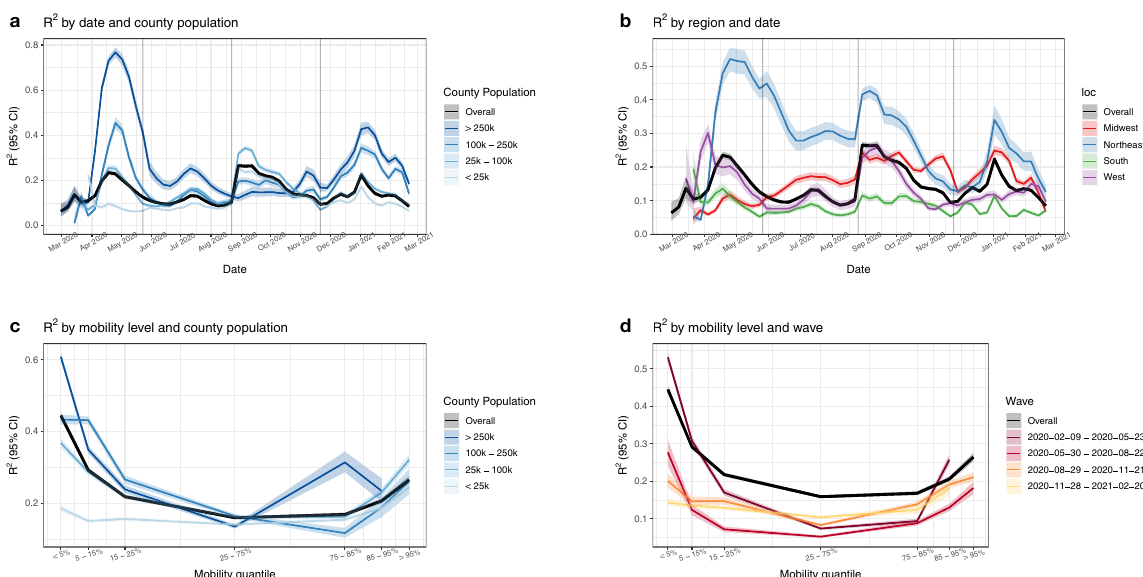
Fig. 5 Model performance. a R 2 per week, overall, and by county population. b R 2 per region and overall. At these coarse levels, models fi t the best during April – May 2020. Fits were poor in summer and improved in some places during fall and winter, but never return to the initial high levels. c R 2 as a function of the overall level of mobility, further broken down by county population. Mobility contains the most signal in the highest population counties when its overall value is extremely low. d R 2 as a function of the overall level of mobility, further broken down by a wave. Mobility contains the most signal in the fi rst wave at extremely low values. Median (solid lines) and 95% quantiles (shaded) are